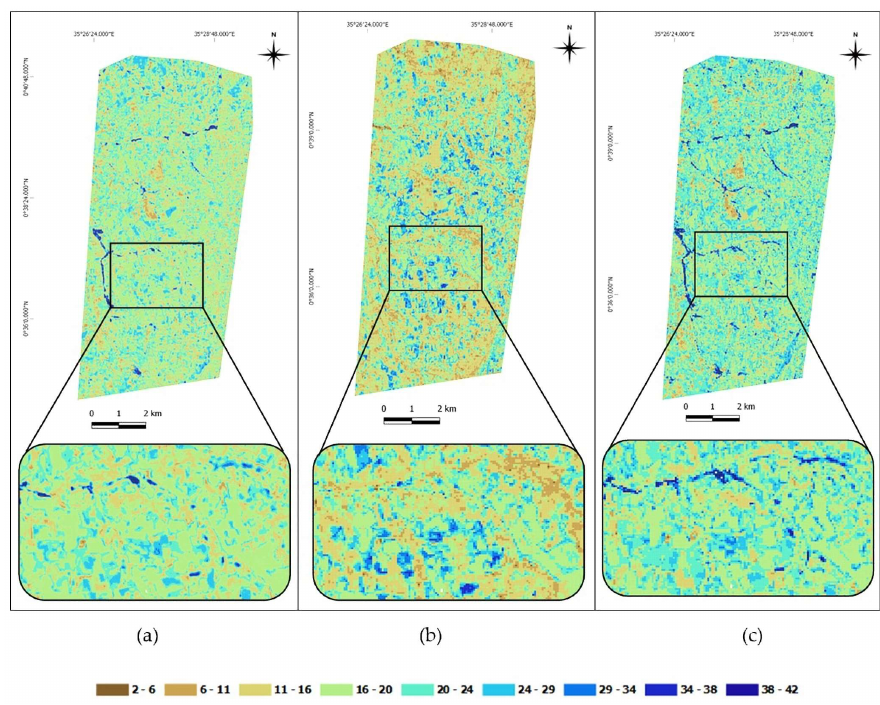
Figure 7. Final SMC map for the Uasin Gishu 18 April 2016 scene: ( a ): pixel-based; ( b ): object-based; ( c ): combined